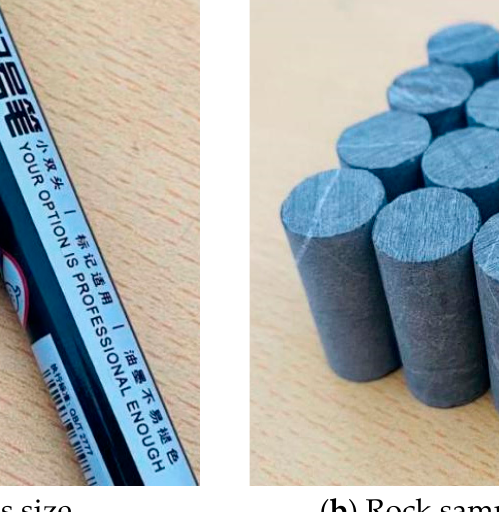
Figure 5. Graphic of rock samples.